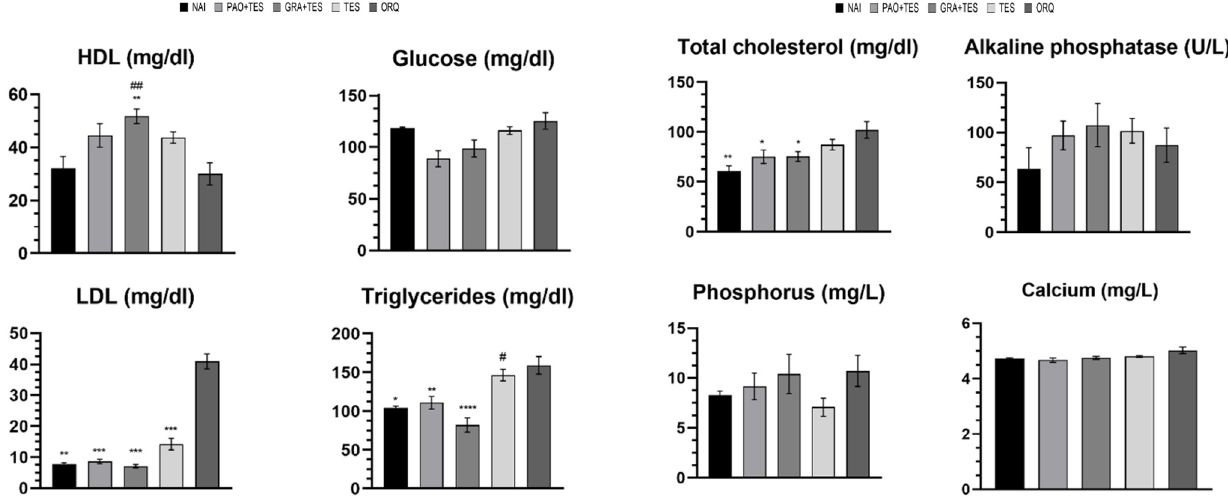
Figure 2. Effect of treatments over 45 days on blood biochemical parameters. NAI: control naïve group; PAO + TES: orchiectomized group treated with purified annatto oil (200 mg/kg, p.o.) + testosterone (7 mg/kg, IM); GRA + TES: orchiectomized group treated with PAO granules (200 mg/kg, p.o., Chronic ® ) + testosterone (7 mg/kg, IM); TES: orchiectomized group treated only with testosterone (7 mg/kg, IM); ORQ: orchiectomized group treated only with water. *: p < 0.05; **: p < 0.01; ***: p < 0.001; ****: p < 0.0001 compared with ORQ; #: p < 0.05; ##: p < 0.01 compared with NAI.